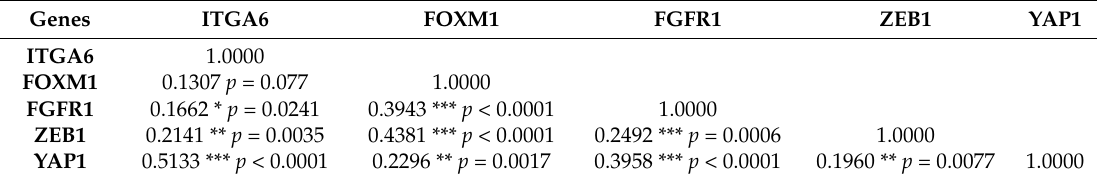
Table 2. Inter-genes correlations in the Rembrandt database ( n = 184). Values correspond to